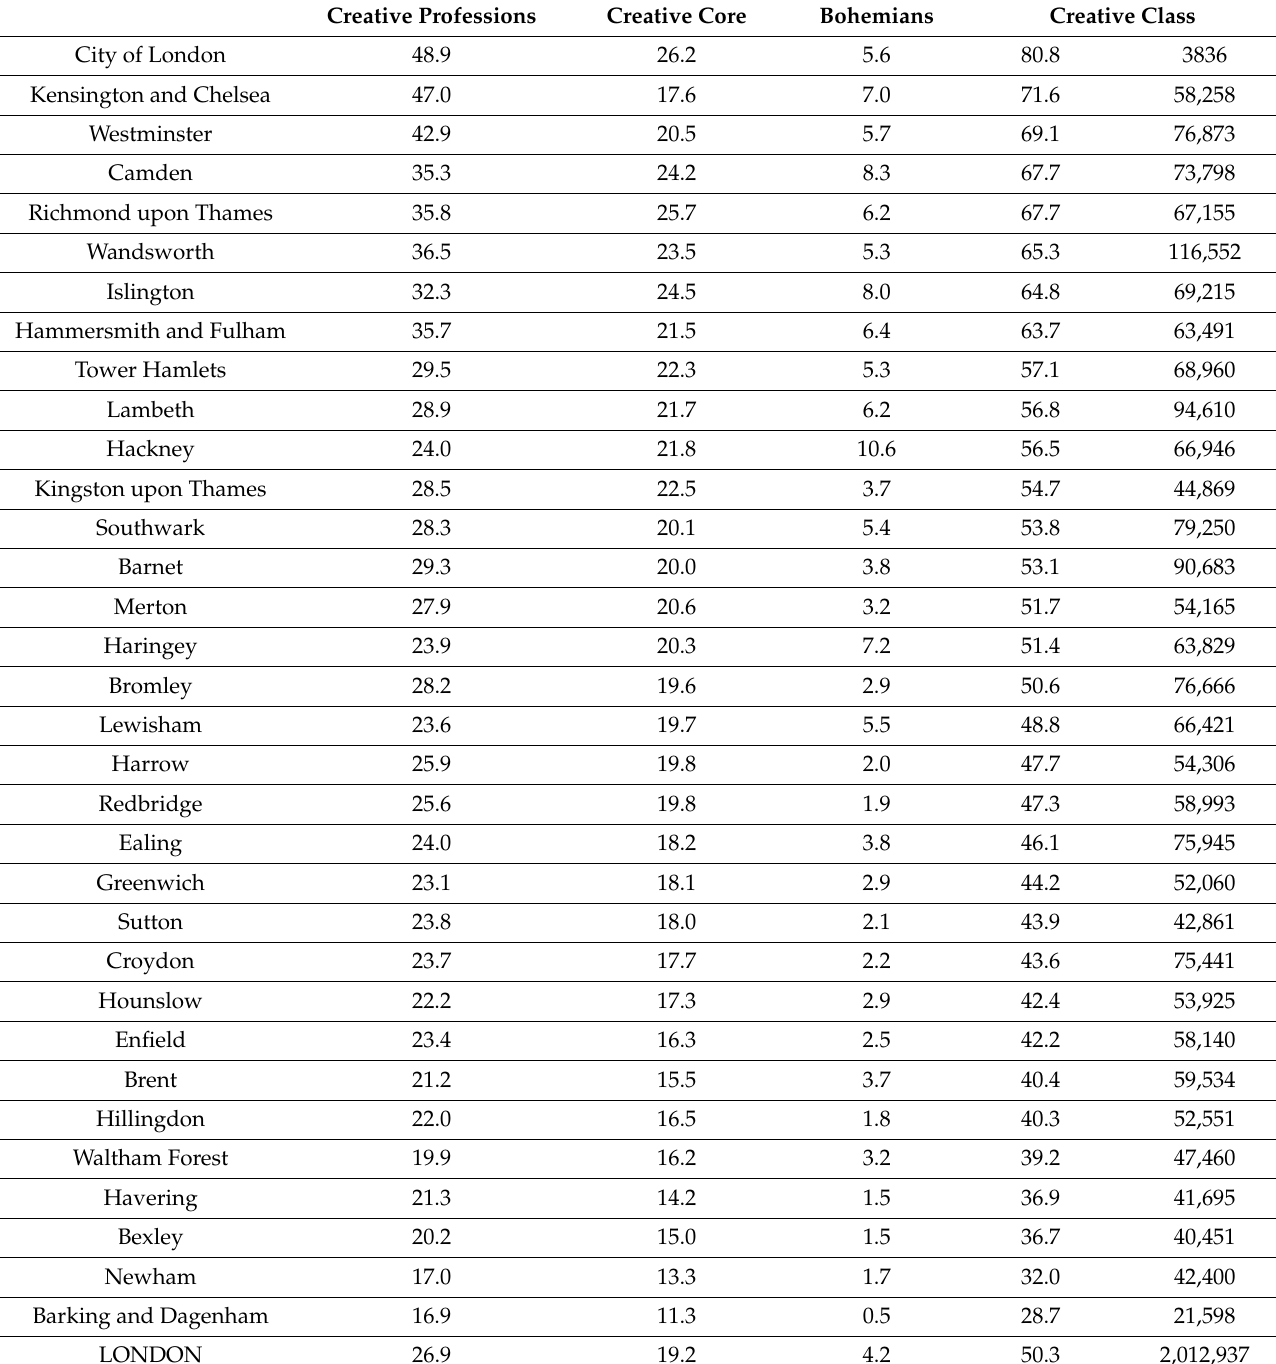
Table 2. Creative Class and its internal distribution—London